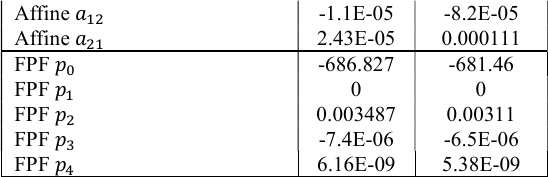
Table 4 Calibration results for the physical model.